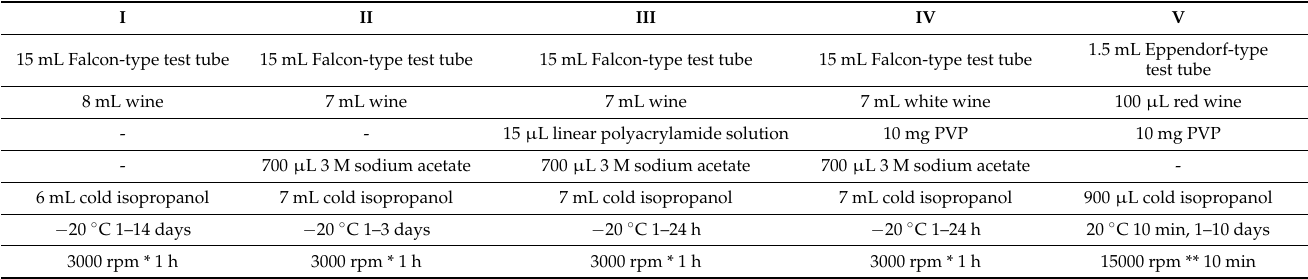
Table 1. Elements of sample preparation stages by precipitation of wine debris by centrifugation with pre exposure with precipitators and co-precipitators.